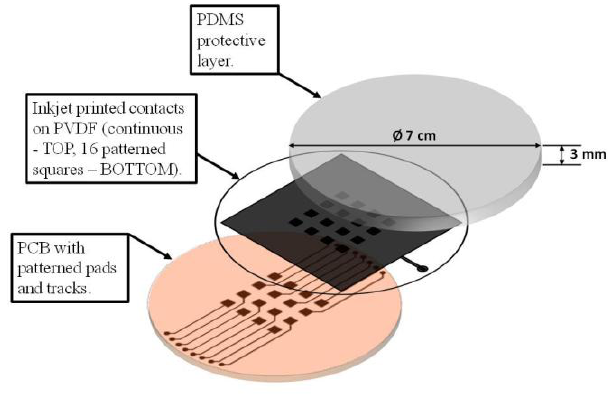
Figure 2. Tactile sensor made of an array of piezoelectric polymer